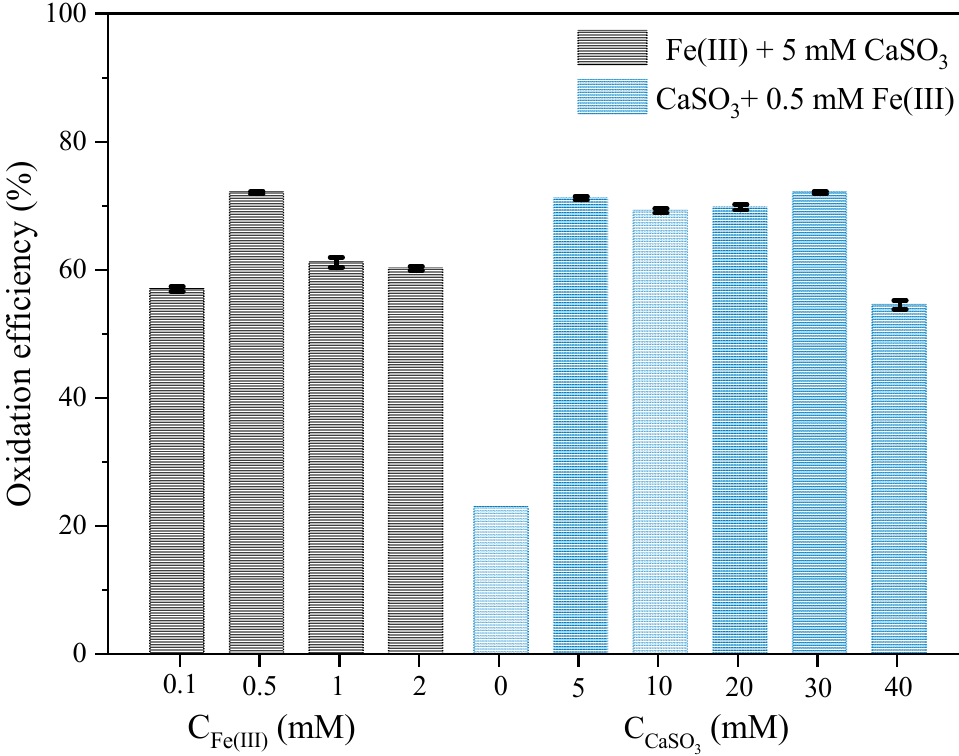
Figure 2. Effect of dosage of Fe(III)/CaSO 3 on the oxidation efficiency of As(III) in the Fe(III)-CaSO 3 system after a reaction time of 60 min. Initial conditions: [As(III)] = 5 μ M, pH 6.0, air bubbling at